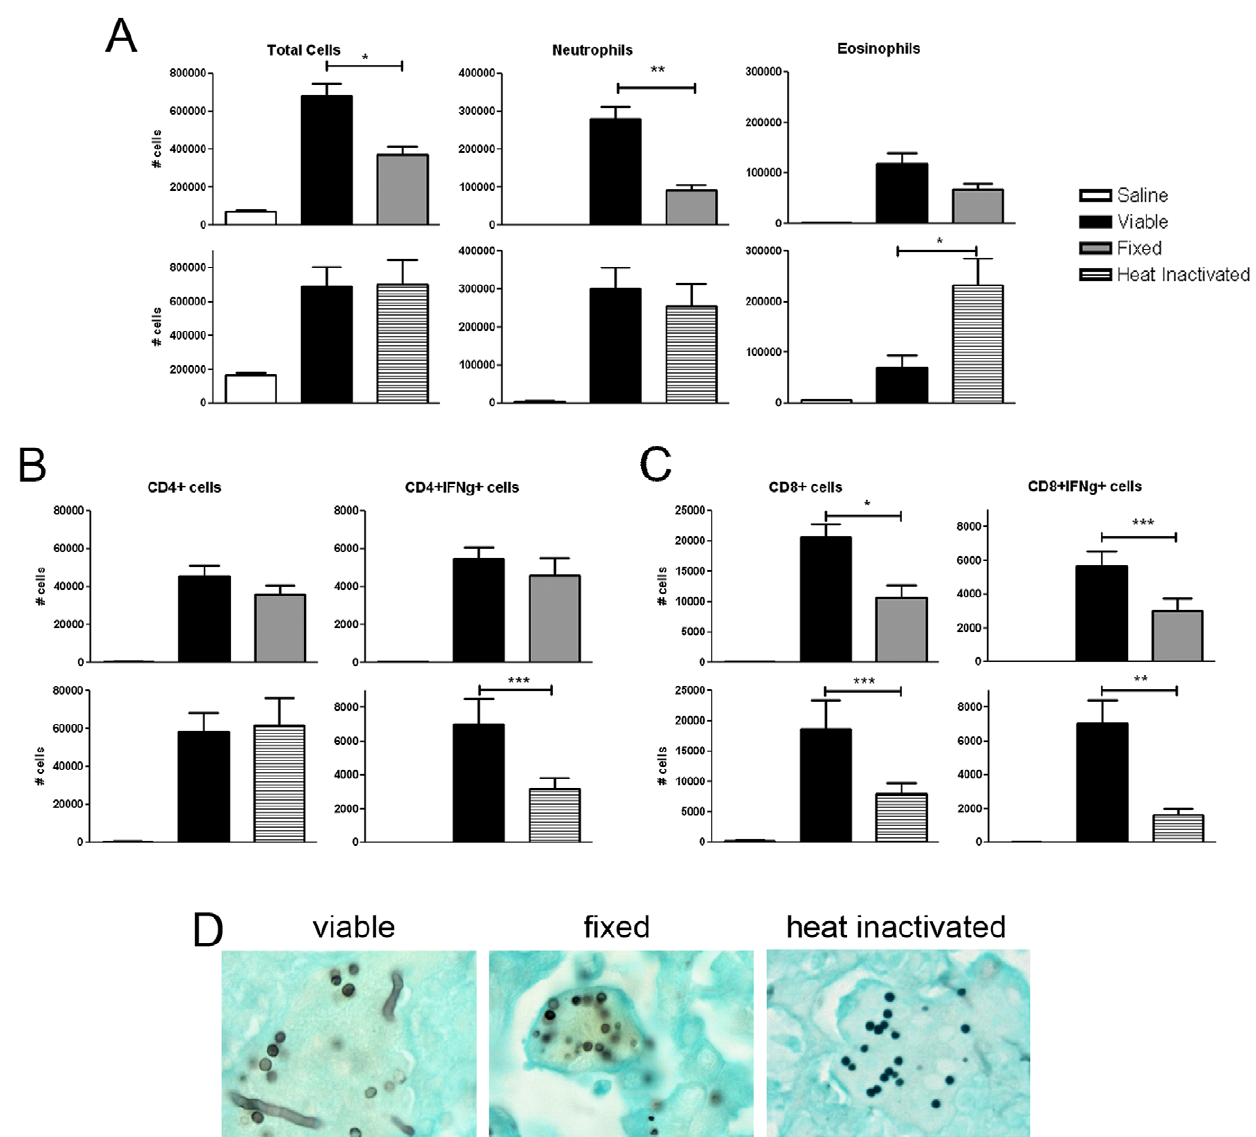
Figure 4. Airway recruitment of IFN- c -producing CD8 + T-cells is decreased in response to p -formaldehyde-fixed or heat-inactivated A.fumigatus conidia. A, total # of BALF cells, neutrophils, and eosinophils. B, BALF CD4 + and CD4 + IFN- c + T-cell composition. C, BALF CD8 + and CD8 + IFN- c + T-cell composition. D, GMS stained (40 6 ) mouse lungs depicting germ tube formation in mice that aspirated viable (left panel), and lack of germ tube formation in mice that aspirated fixed or heat-inactivated conidia (center, right panels). Data depicted in A–C are a summary of two experiments with groups of 5 (saline control) or 10 (viable or non-viable conidia). Histology panels depicted are representative of 5 mice per group with one lung section analyzed per animal. *p , 0.01 , **p , 0.001 , ***p , 0.05